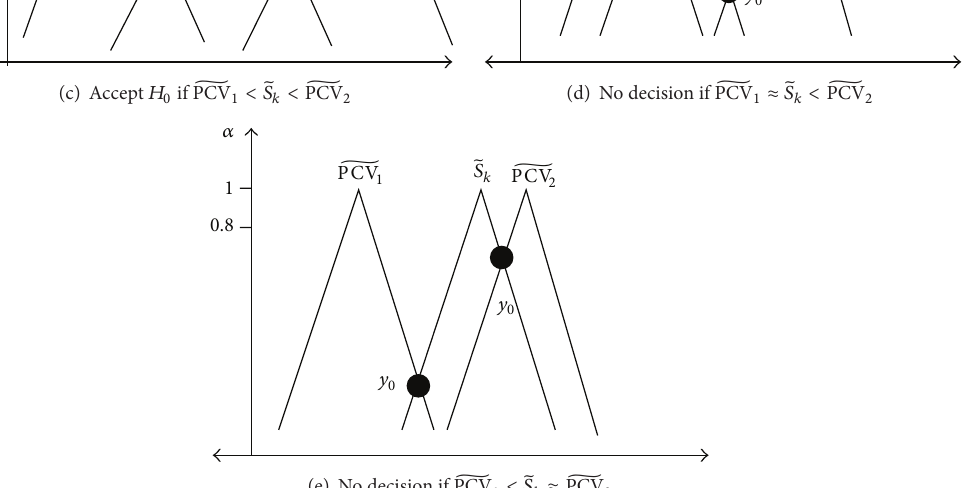
Figure 3: Decision criteria for 𝛼 -cuts approach to group sequential testing 𝐻 0 : 𝜇 = 𝜇 0 versus 𝐻 1 : 𝜇 ̸=𝜇 0